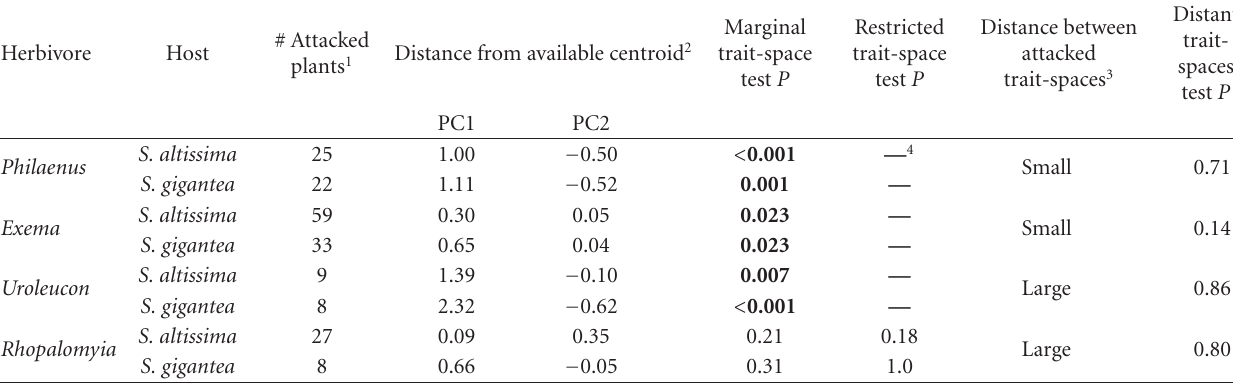
Table 4: Tests of trait-space use on Solidago altissima and S. gigantea for four Solidago herbivores. P -values in bold are significant at α = 0.05. Herbivore Host